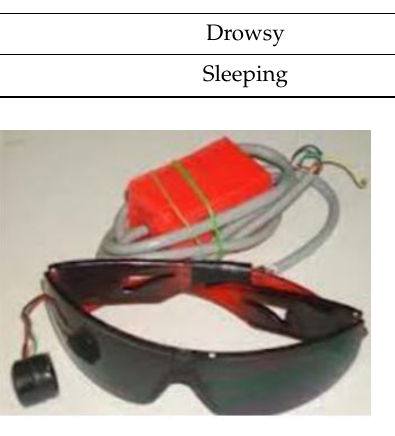
Figure 4. Eye blink sensor [51,52].